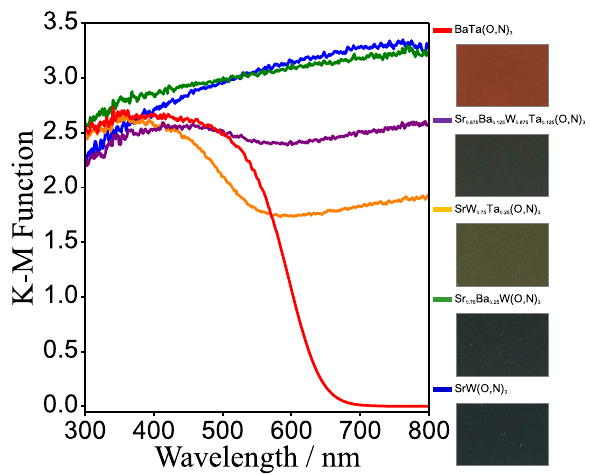
Fig. 4 UV–Vis diffuse reflectance spectra of Sr 1 - x Ba x W 1 - y Ta y (- O,N) 3 : blue x , y = 0,0; gree x , y = 0.25,0; orange x , y = 0,0.25; purple x , y = 0.125,0.125; and red BaTa(O,N) 3 crystal structures synthesized by thermal ammonolysis of oxide precursors at 900–950 (cid:3) C for 10–40 h under an NH 3